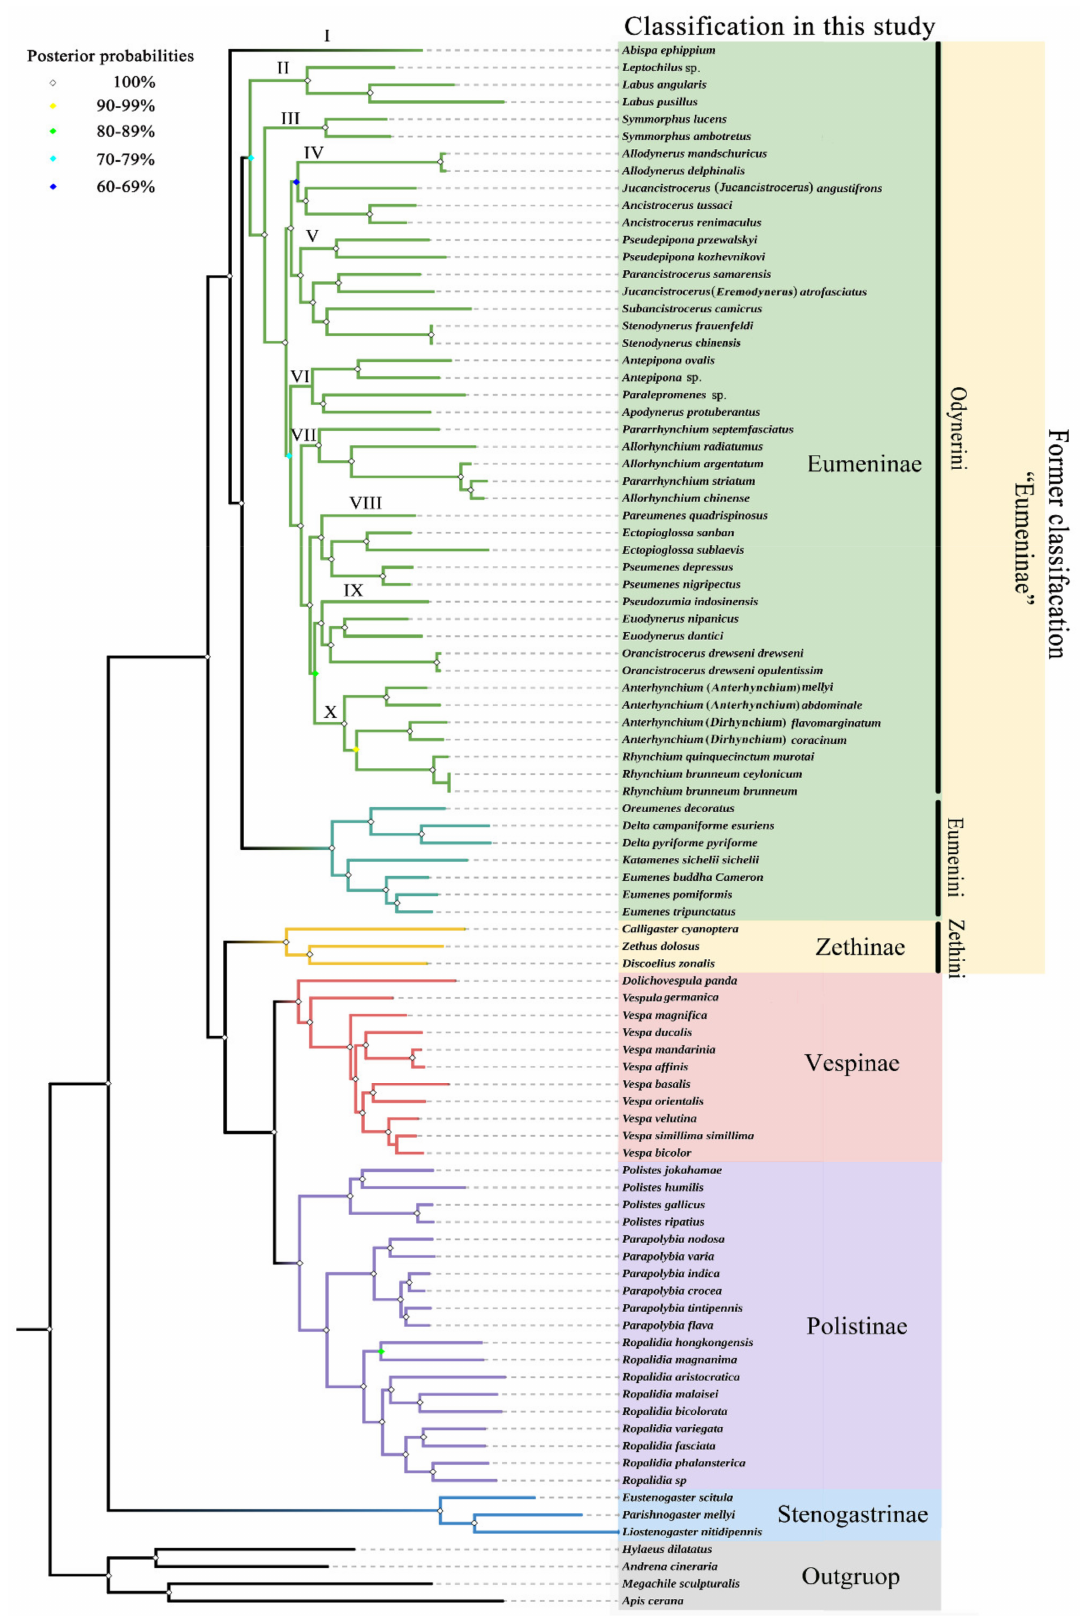
Figure 8. Phylogenetic tree of Vespidae inferred from PCG and PCGR by BI. Each node shows the Bayesian posterior probability (PP)